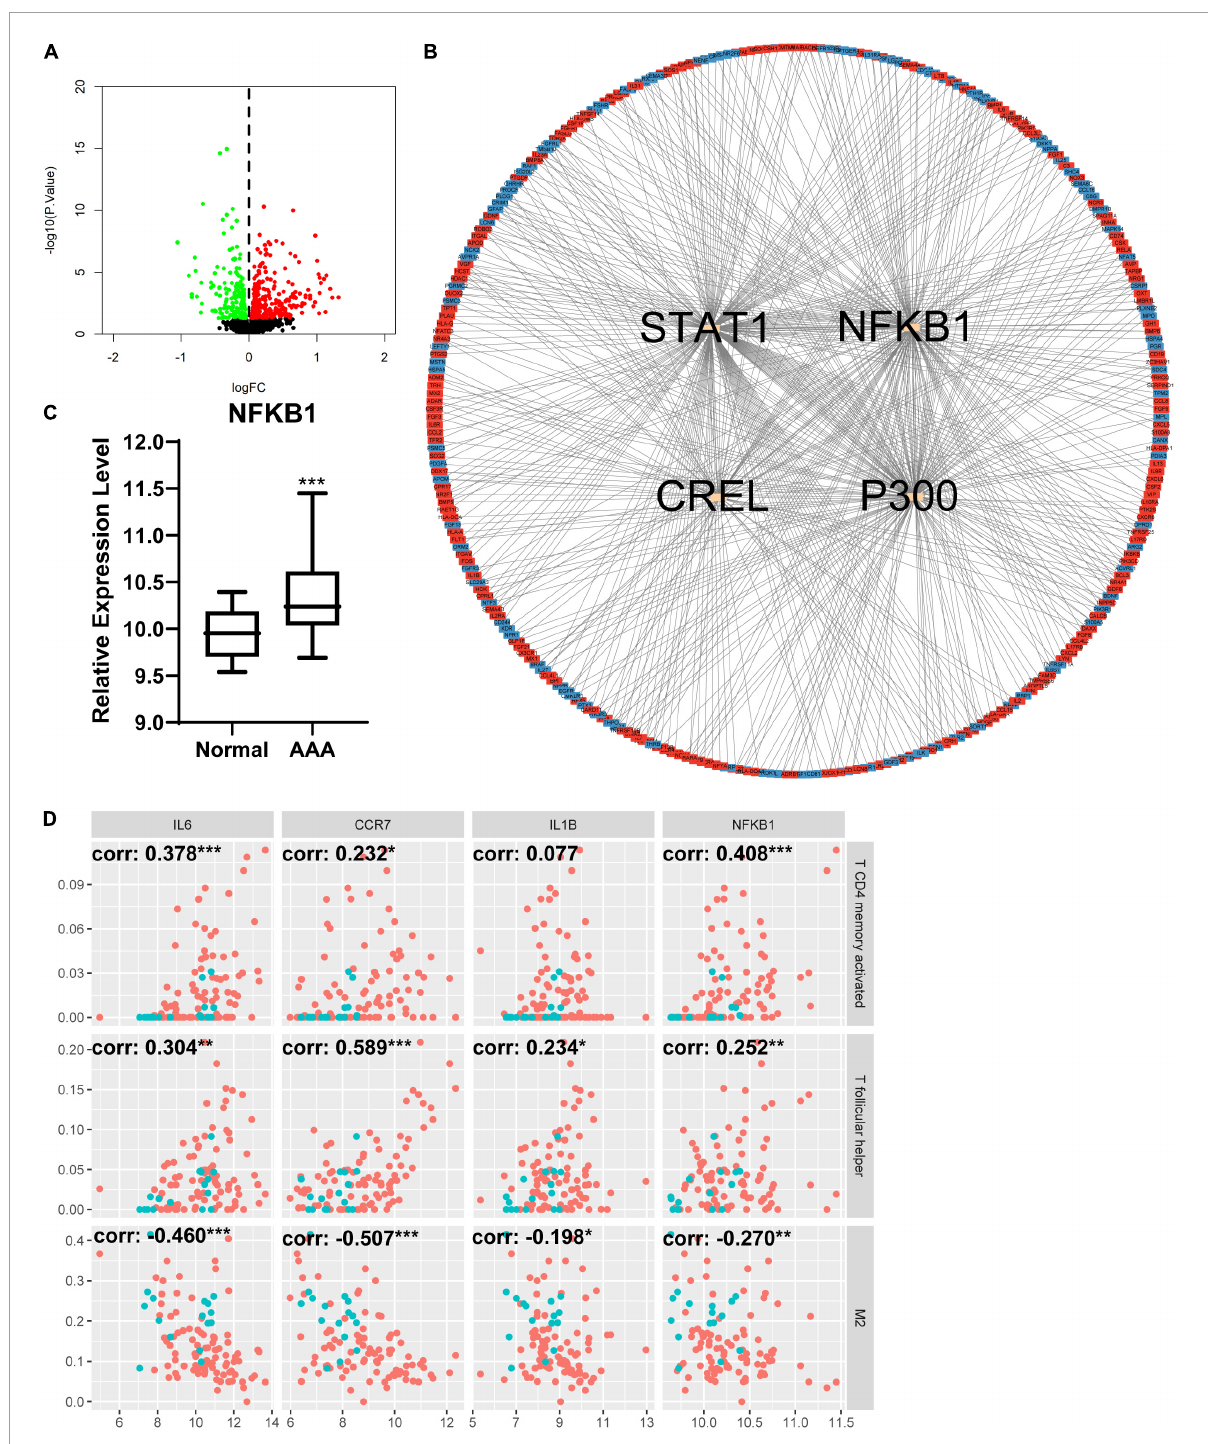
FIGURE6 Differentially expressed immune and inflammation-related genes (DEIRGs) between normal abdominal aorta group and AAA group. (A) The volcano plot of DEIRGs between normal abdominal aorta group and AAA group. Dots in green: downregulated gene, dots in red: upregulated gene. (B) The PPI network of DEIRGs and upstream transcription factors. (C) The expression level of NFKB1 in normal abdominal aorta group and AAA group. (D) The relationship between top three upregulated DEIRGs, NFKB1, and significantly changed immune cells. Dots in blue: normal abdominal aorta samples, dots in red: AAA samples. AAA, abdominal aortic aneurysm; PPI, protein–protein interaction; NFKB1, nuclear factor kappa B 1; corr, correlation coefficient. * p < 0.05, ** p < 0.01, *** p <